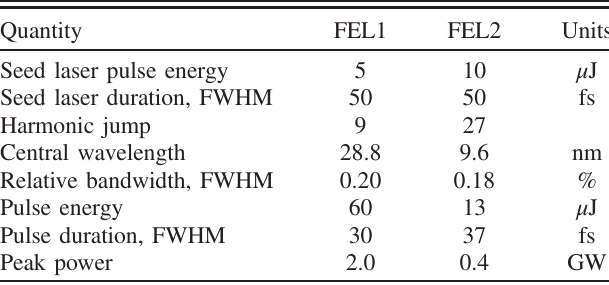
TABLE II. FEL1 and FEL2 input and output parameters. Electron beamlet parameters as in Table I.